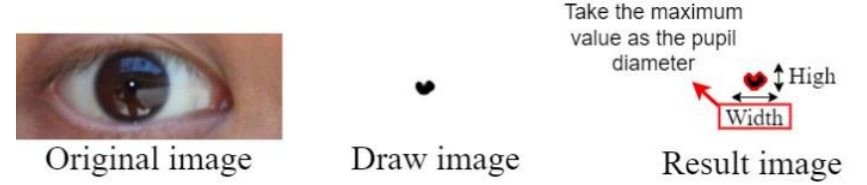
Figure 30. Imperfect pupil image.